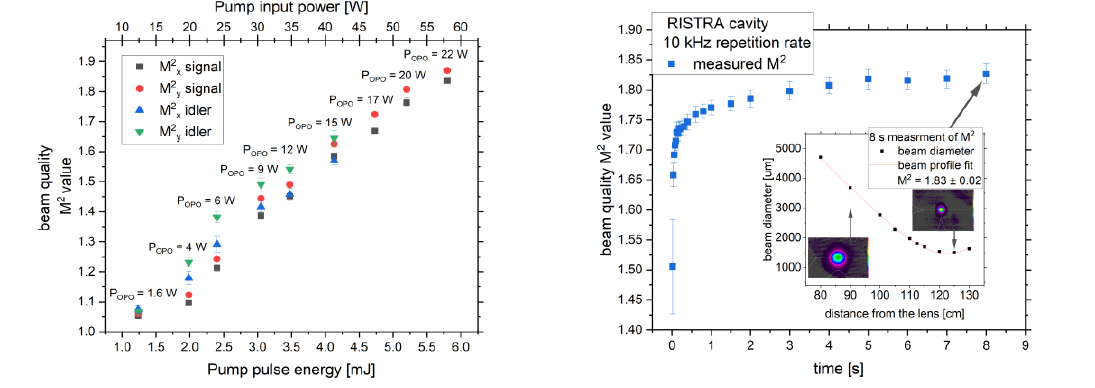
Fig. 1 Left: The OPO output beam M 2 as a function of pump pulse energy at the 10 kHz repetition rate. The labels indicate the total (signal + idler) OPO output power from the non-planar RISTRA cavity. Right: The M 2 time evolution measured with 20 ms resolution at maximum output power of 22 W from ZGP OPO in RISTRA cavity. The inset graph shows the example of a beam profile for the last point in the main